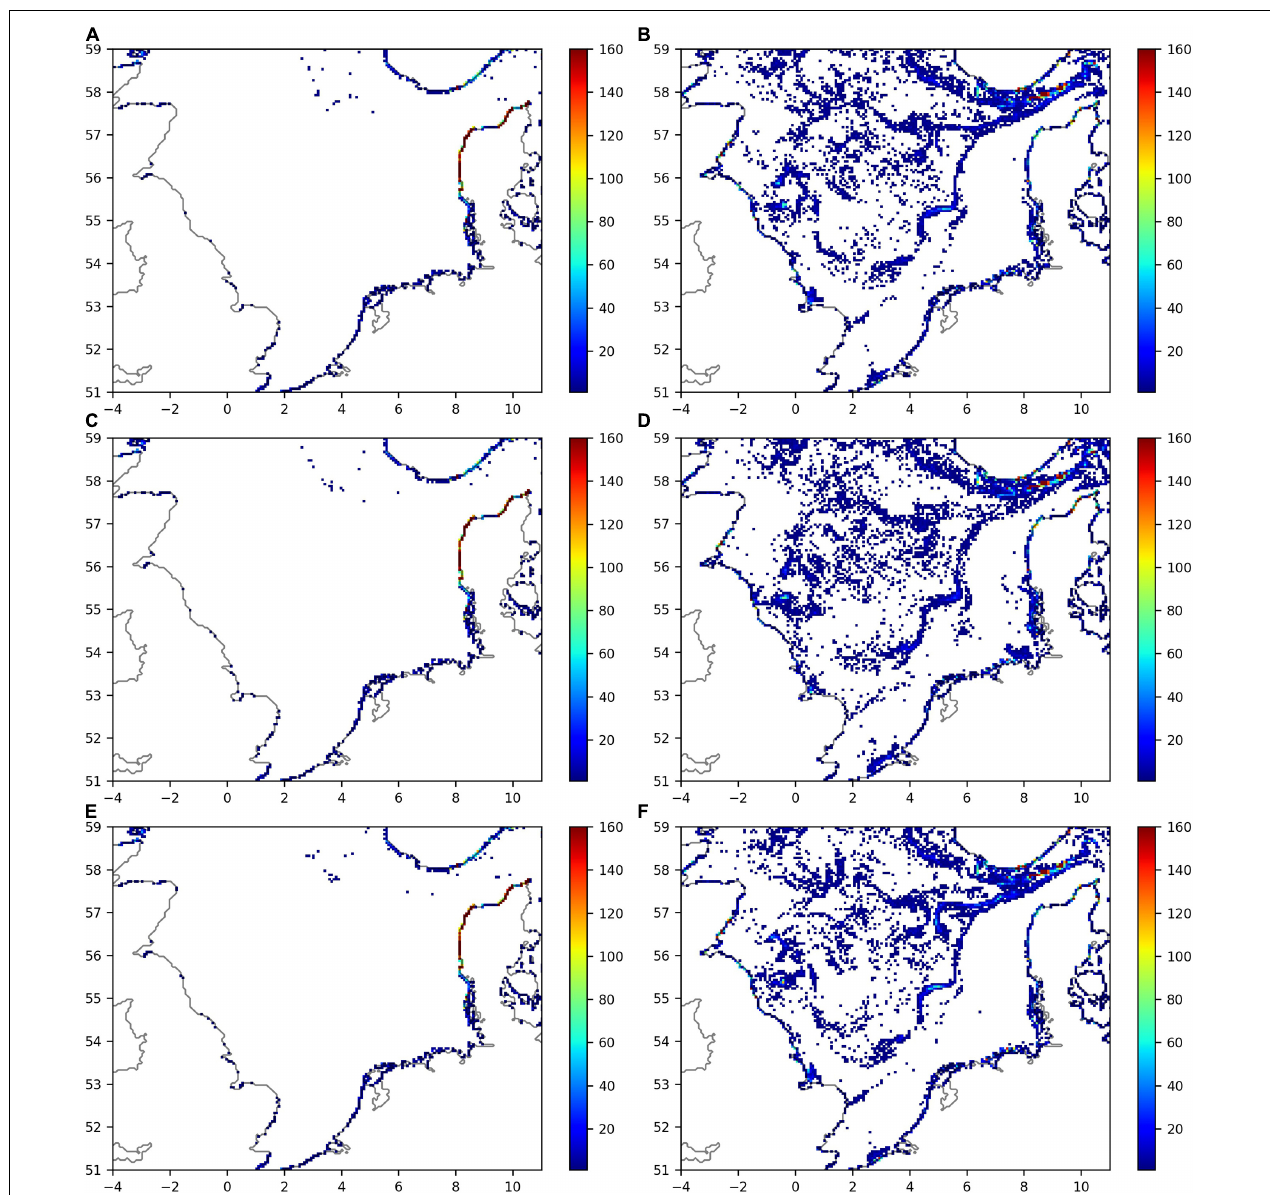
FIGURE 3 | Particle densities (number of particles per grid cell) for the instantaneous release scenario on 30 December 2017. (A) Floating particles (0.06 ms − 1 ), (B) sinking particles ( − 0.004 ms − 1 ), (C) floating particles (0.05 ms − 1 ), (D) sinking particles ( − 0.0015 ms − 1 ), (E) floating particles (0.07 ms − 1 ), (F) sinking particles ( − 0.006 ms − 1 ). Coordinates are latitude and longitude in